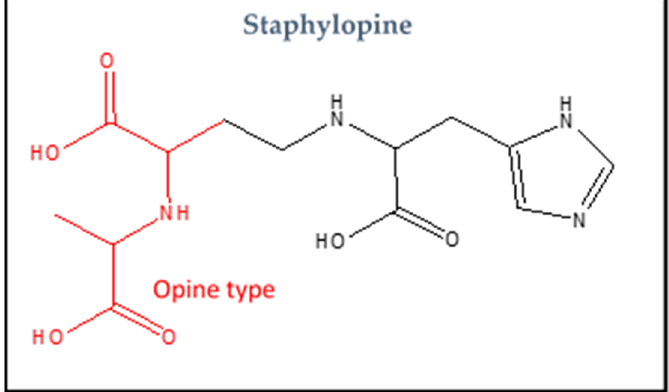
Figure 2. The structure of metallophore staphylopine.